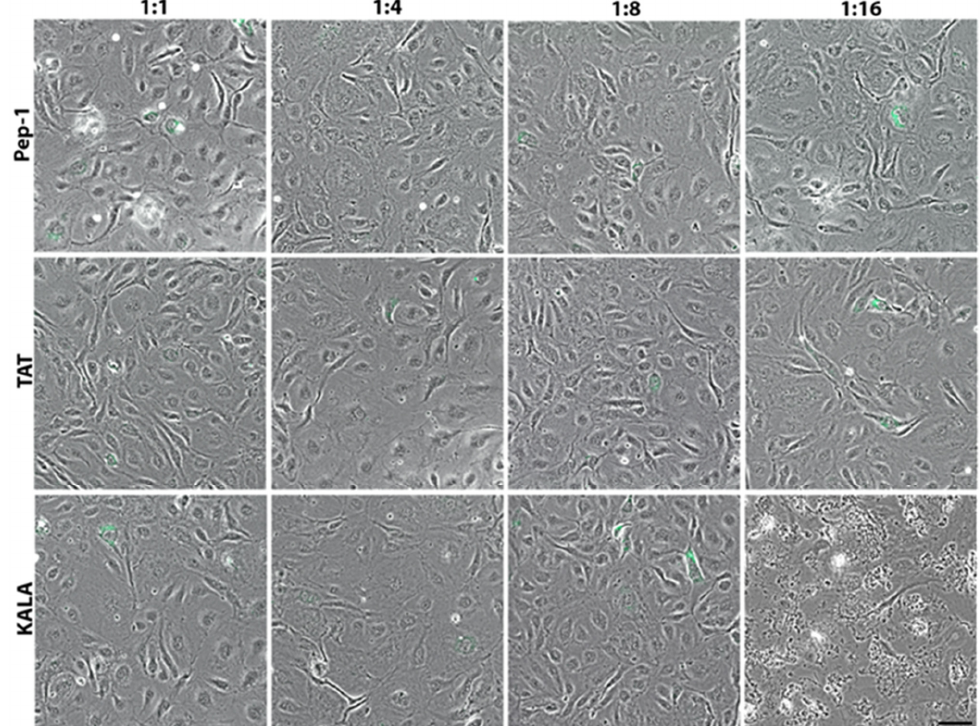
Figure 2. Results of 24 h culture in the presence of complexes in CRs of 1:1, 1:4, 1:8 and 1:16. The complexes were formed using incubation of 1 μ g pmaxGFP with chosen CPPs at 21 °C for 15 min. Bar = 50 μ m. CR, charge ratio.